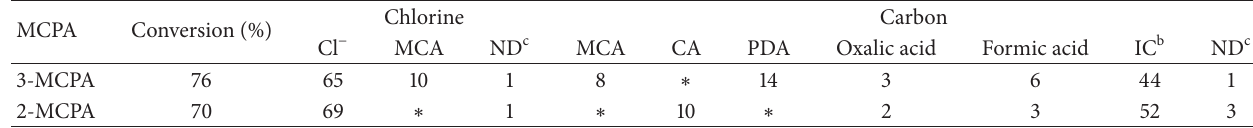
Table 2: Elemental yields of products at 240 min from CGDE of MCPAs a .